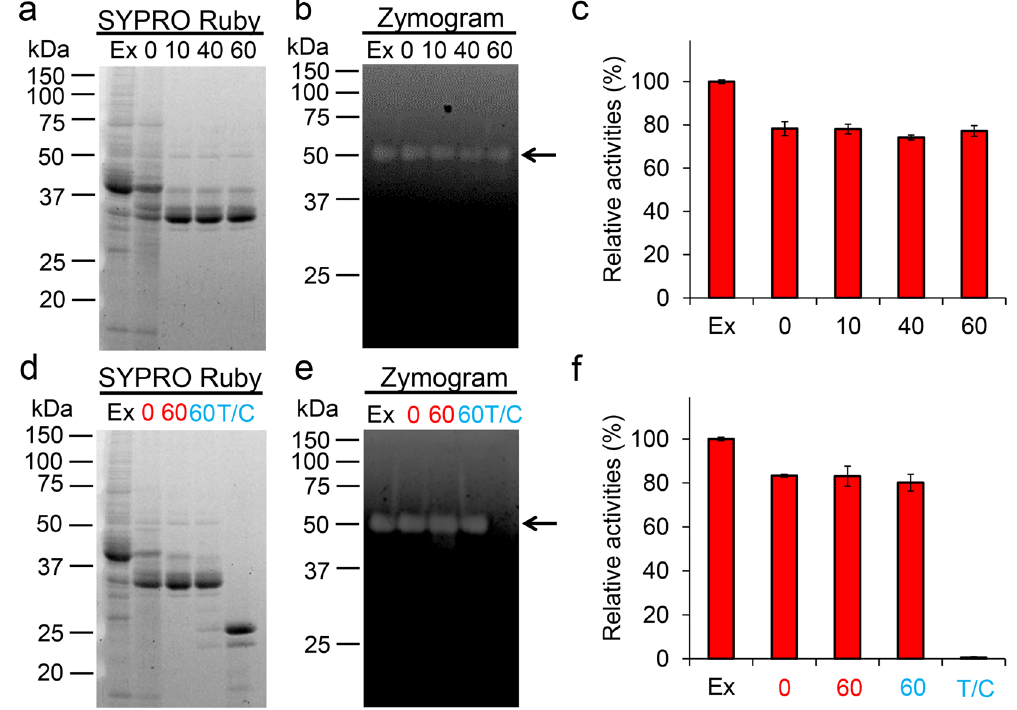
Figure 5. Functional stability of chicken Chia against endogenous pepsin. Soluble proteins obtained from chicken glandular stomach were incubated at pH 2.0 and 37 °C for 0, 10, 40 and 60 min ( a – c ). After the incubation, the samples were further incubated at pH 7.6 for 1 hour with trypsin and chymotrypsin in extract to the reaction ( d – f ). The samples were analyzed as follows: ( a , d ) SDS-PAGE and following SYPRO Ruby staining, ( b , e ) zymography, ( c , f ) chitinolytic activities. Ex, extract only; T/C, trypsin and chymotrypsin only; numbers, incubation time at pH 2.0 (red) or at pH 7.6 (light blue). Values in ( c , f ) represent mean ± SD conducted in